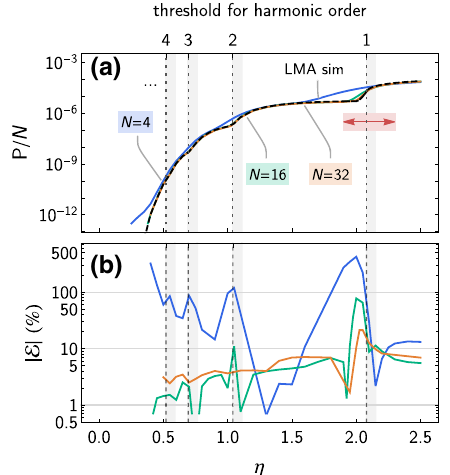
Fig. 5 a Paircreationprobability P foraphotonwithenergyparameter η colliding with a circularly-polarised plane-wave of peak amplitude ξ = 0 . 2 and duration equivalent to a number of wavelengths N . Results are plotted from QED for N = 4 (blue), N = 16 (green) and N = 32 (orange) and LMA-based simulations (black, dashed). b Percentage difference between simulation and direct QED calculations. Vertical, greydashedlinesgivethethresholdin η toaccessanadditionalharmonic channel. The change in the spectrum in the region around the n = 1 channel crossing, highlighted in red, is shown in detail in Fig. 6